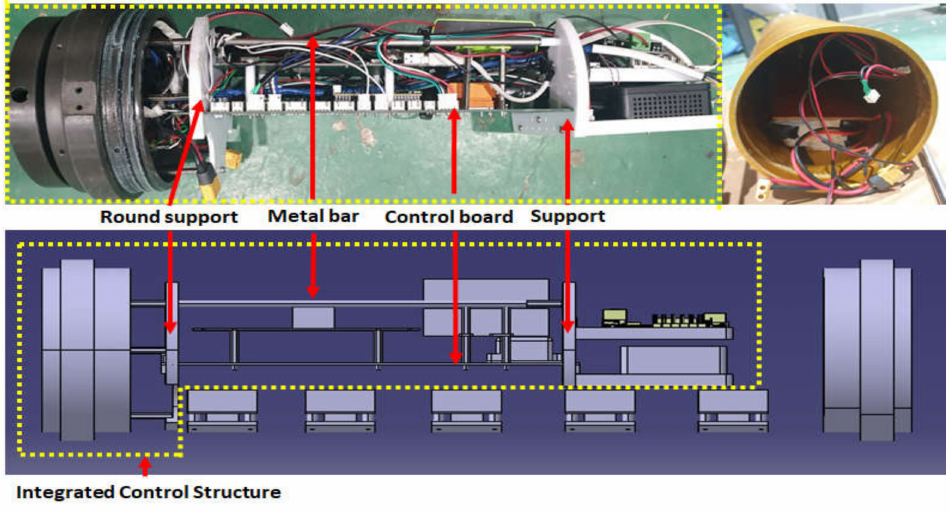
Figure 7. Configuration of inner structure of the cylinder.